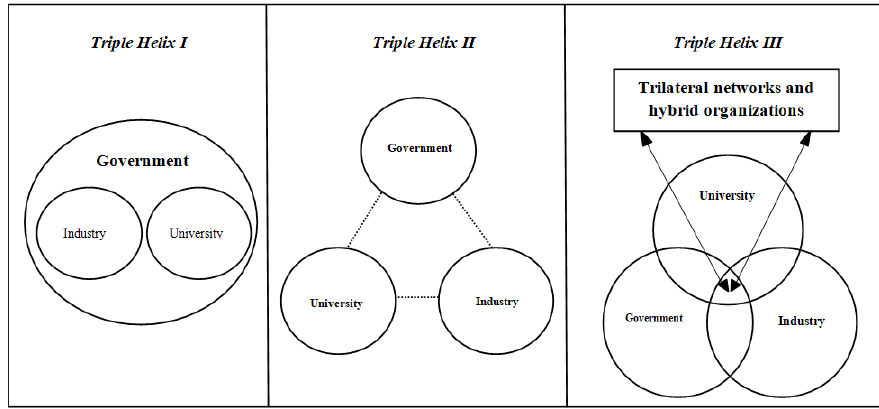
Figure 2. Models of triple helix model of innovation: triple helix model of innovation 1, triple helix model of innovation 2 and triple helix model of innovation 3 (source: created by authors with a base on Etzkowitz & Leydesdorff, 2000, p.